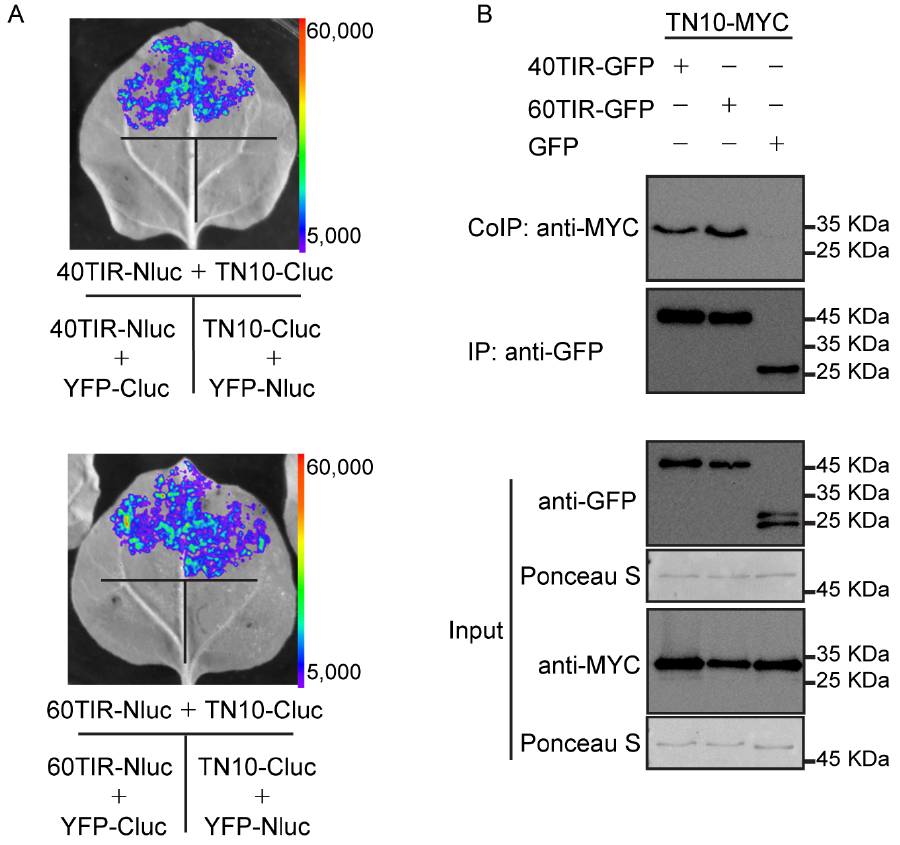
Figure 2. The Toll/interleukin-1 receptor (TIR) domains of TNL40 and TNL60 interact with TN10 in planta . ( A ) Images of N. benthamiana leaves two days after inoculation with indicated constructs in a firefly split-luciferase complementation imaging (LUC) assay. The coding sequence (CDS) of TN10 was fused to the C-terminal fragment to firefly luciferase ( Cluc ) and the CDS of TNL40TIR or TNL60TIR was fused to the N-terminal fragment to firefly luciferase ( Nluc ). The indicated constructs were transiently co-expressed in 4-week-old N. benthamiana leaves. Yellow fluorescence protein (YFP)-Cluc and YFP-Nluc were used as the negative controls. ( B ) The interaction analysis of TNL40TIR-GFP or TNL60TIR-GFP with TN10-MYC in a co-immunoprecipitation (Co-IP) assay 16 h after transfection of Arabidopsis Col-0 protoplasts. The expression of GFP with TN10-MYC was used as a negative control. Proteins were detected by immunoblotting using anti-GFP and anti-MYC antibodies.